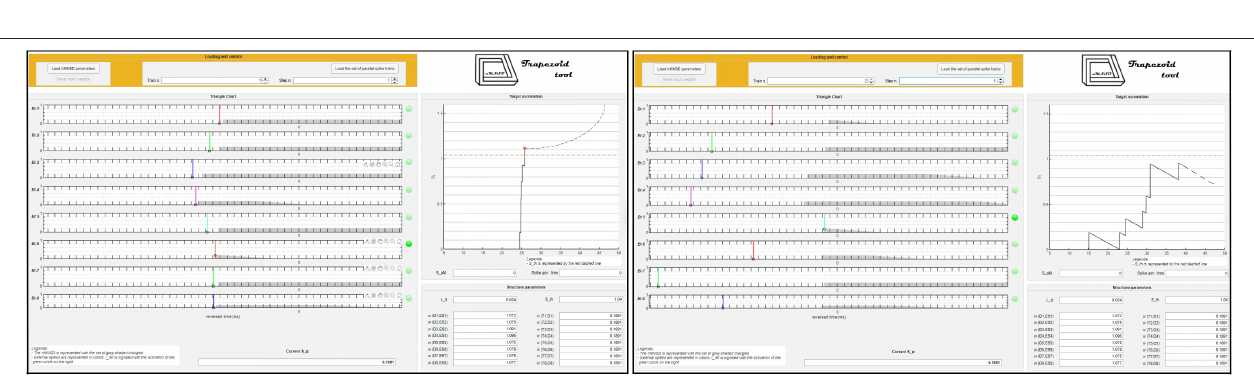
FIGURE 12 | Representation on the trapezoid chart of the No-Go structure after the training, when crossed by 2 parallel spike trains. Left : The No-Go structure is stimulated with a No-Go trial (correctly recognized). Right : The No-Go structure is stimulated with a Go trial (that is not recognized by the structure).